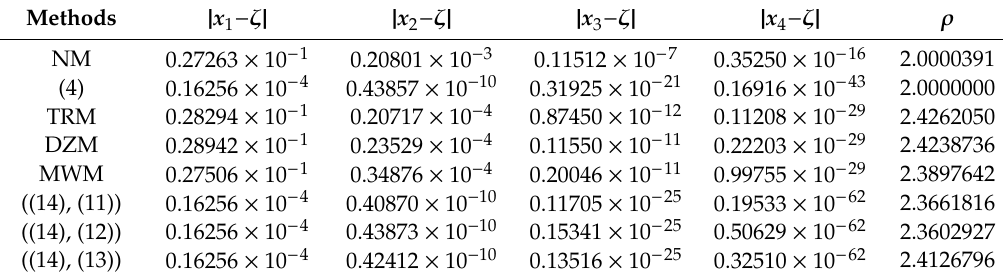
Table 5. Numerical results for function f 5 ( x ) .